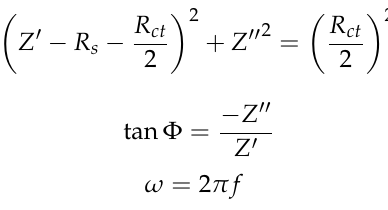
Figure 3. Optimization of elution time ( a ) and rebound time ( b ).